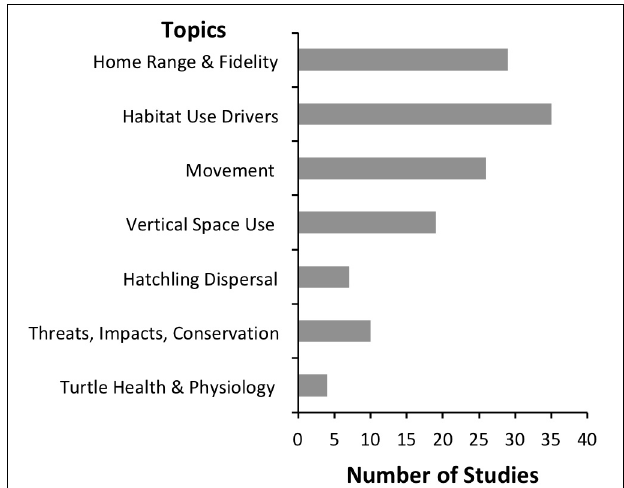
FIGURE 5 | Broad topics investigated by marine turtle acoustic telemetry studies with the number of studies ( n = 48) that explored or discussed each topic